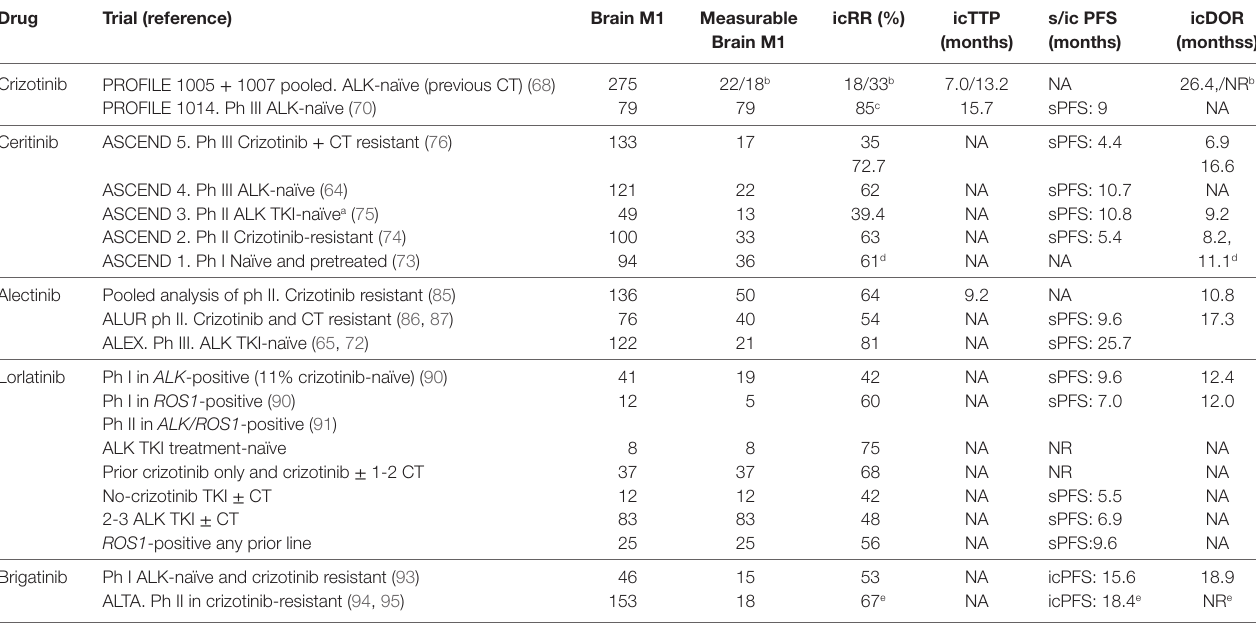
icRR (%) icTTP s/ic PFS Brain M1 (months) (months)